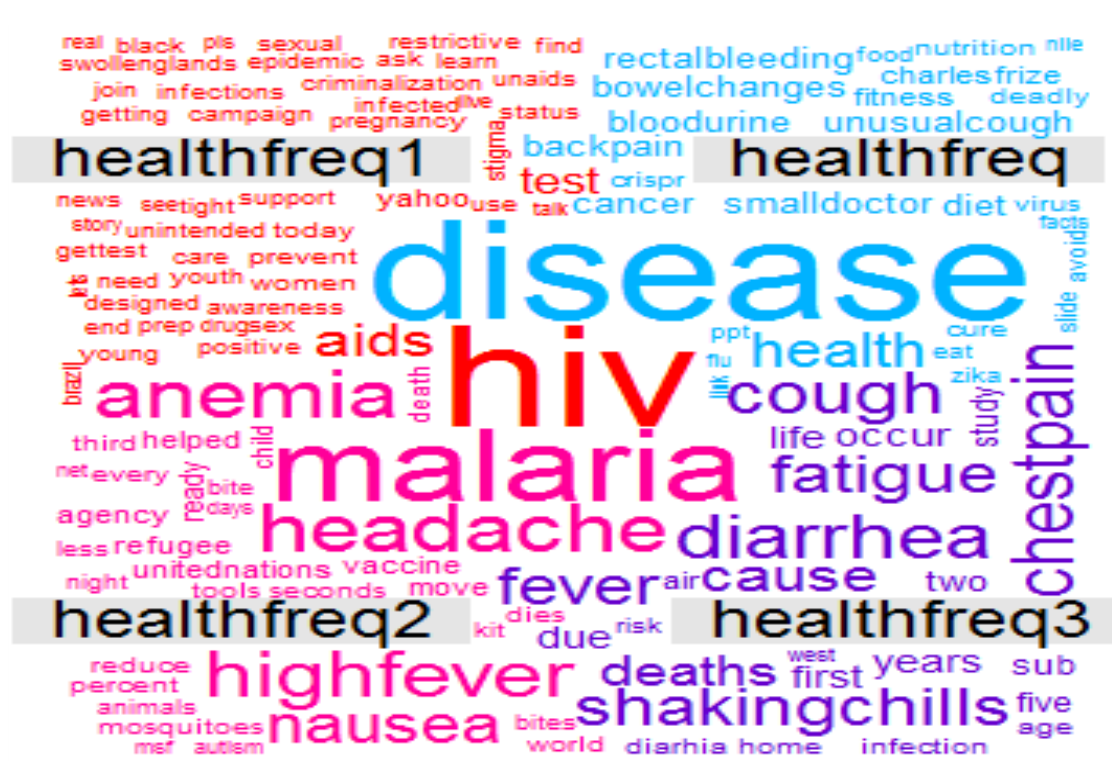
Figure 5. Comparing of health trends of WordCloud using proposed